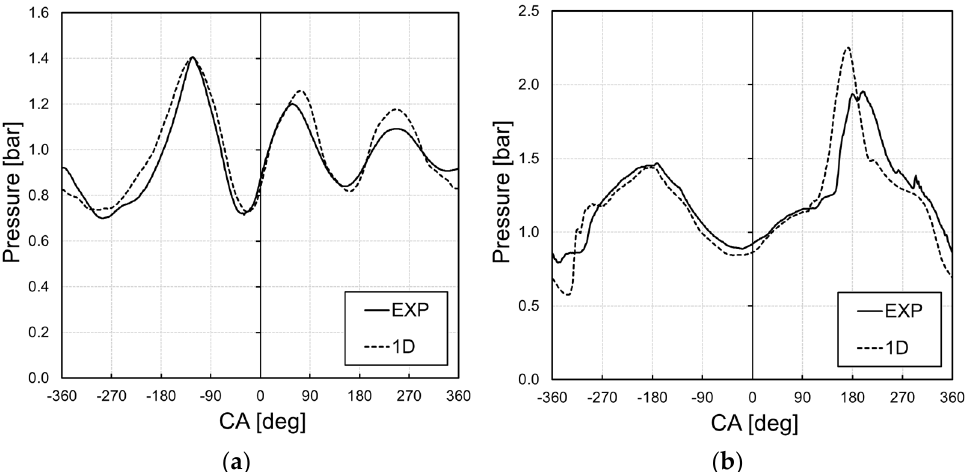
Figure 1. Comparison between 1D GT-Power results and pressure measurements ( a ) intake duct; ( b ) exhaust duct.